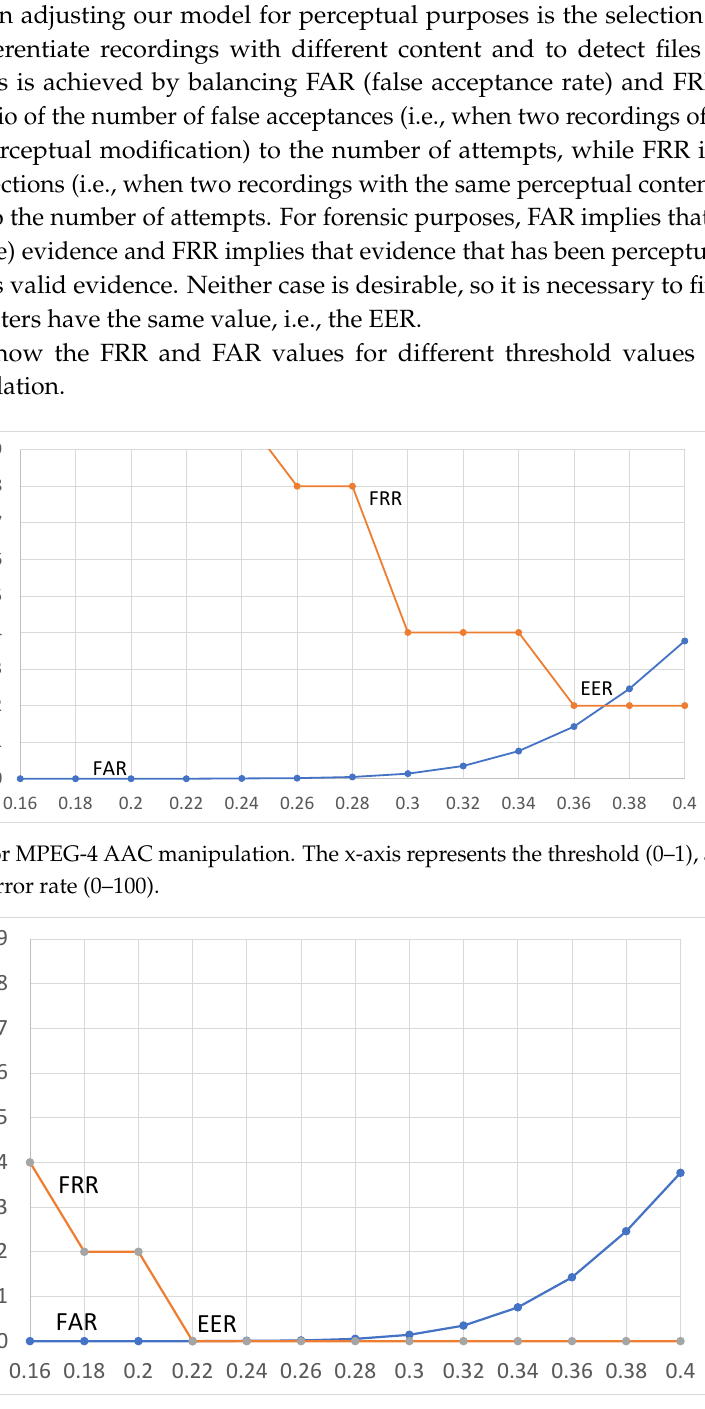
Figure 7. EER for volume adjustment manipulation. The x-axis represents the threshold (0–1), and the y-axis represents the error rate